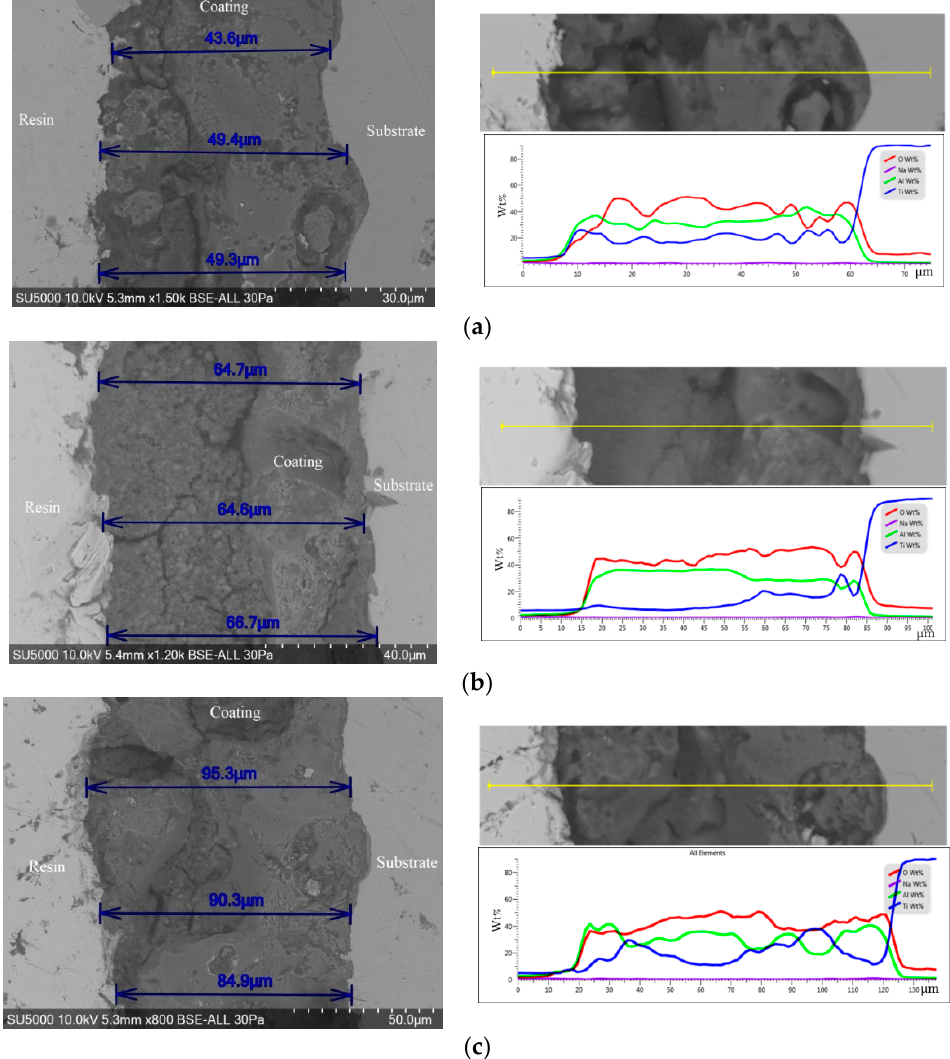
Figure 8. Cross-sectional images and EDS line profiles of the PEO coatings formed in E3 electrolyte after 10, 20 and 30 min treatment period. ( a ) Ti10M/E3; ( b ) Ti20M/E3; ( c ) Ti30M/E3.